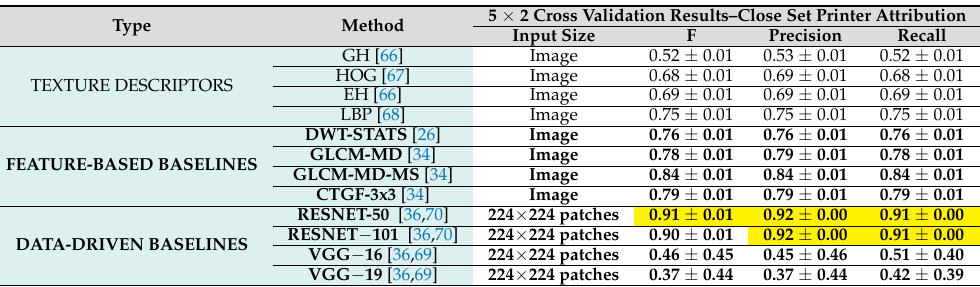
Table 2. Average performance for the source attribution problem. The approaches are divided by category, and boldfaced entries denote the solutions specifically designed for the source printer attribution problem. The best results for each metric are highlighted in